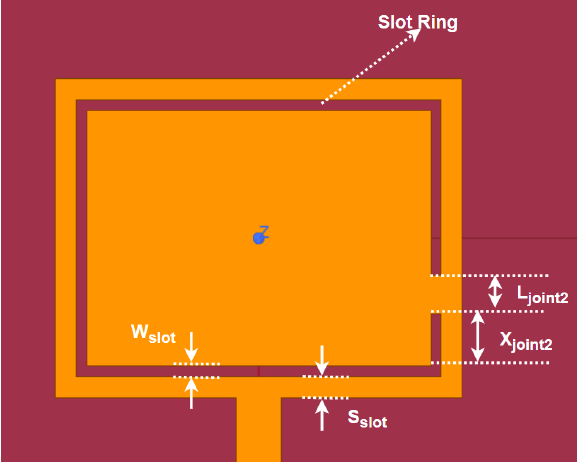
Figure 5. Adding second joint part at the bottom right of ring